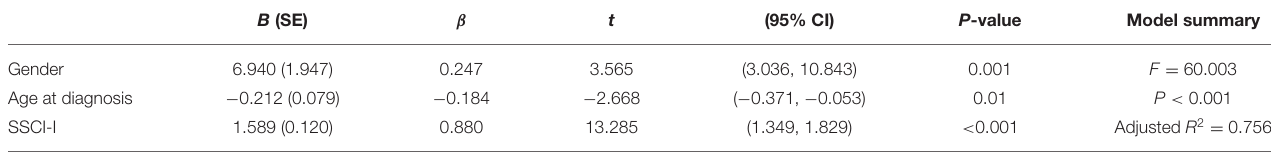
TABLE 3 | Stepwise multiple linear regression analysis per determinant for body image concern in patients with acromegaly.